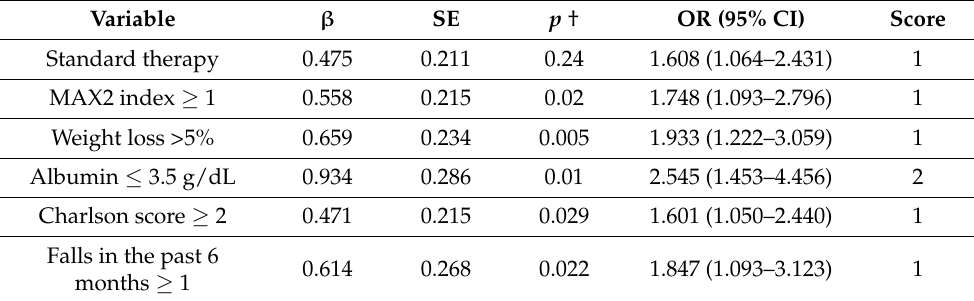
Table 4. Variables significantly associated with unplanned hospitalizations on multivariable analysis.